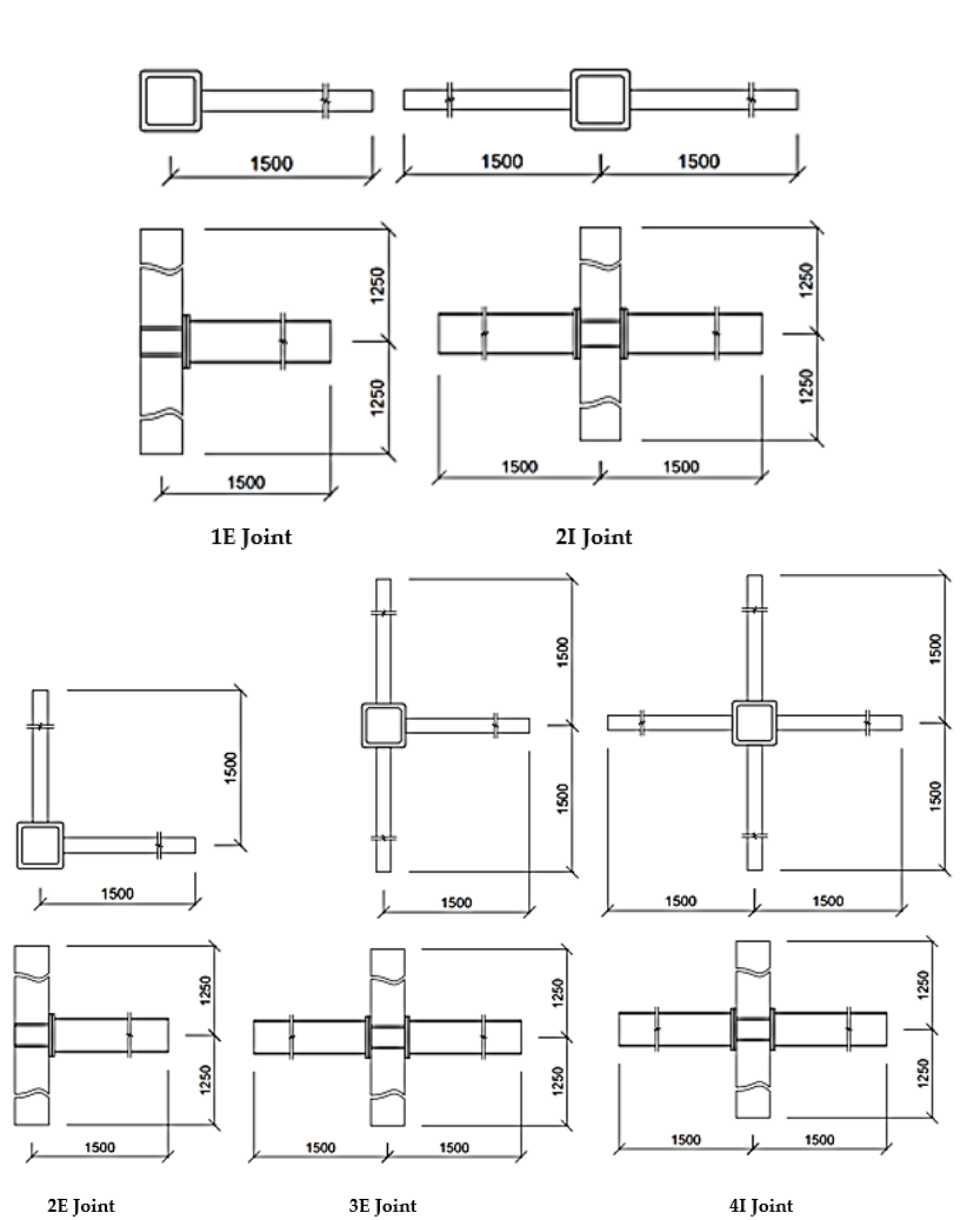
Figure 3. Schematic view of 2D and 3D joints [mm].